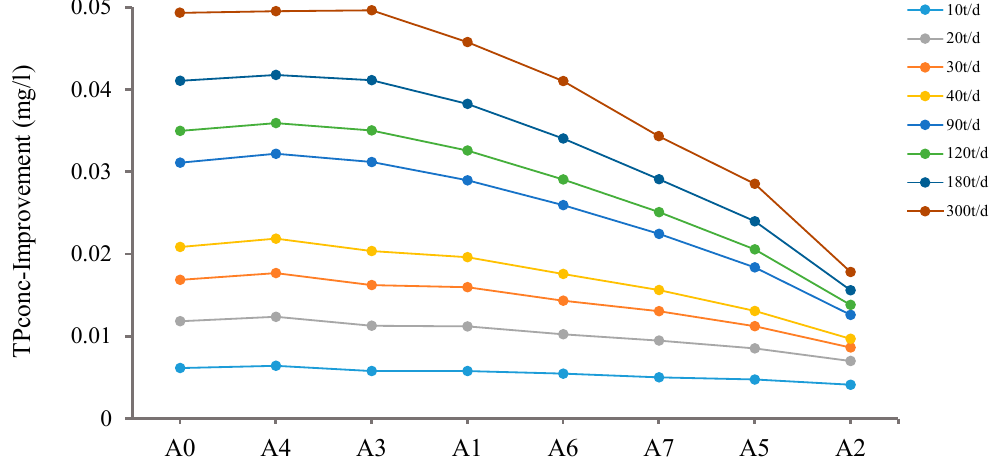
Figure 12. Relationship between the release position and response (average for the simulation period, T1–T4, and base0– base2).